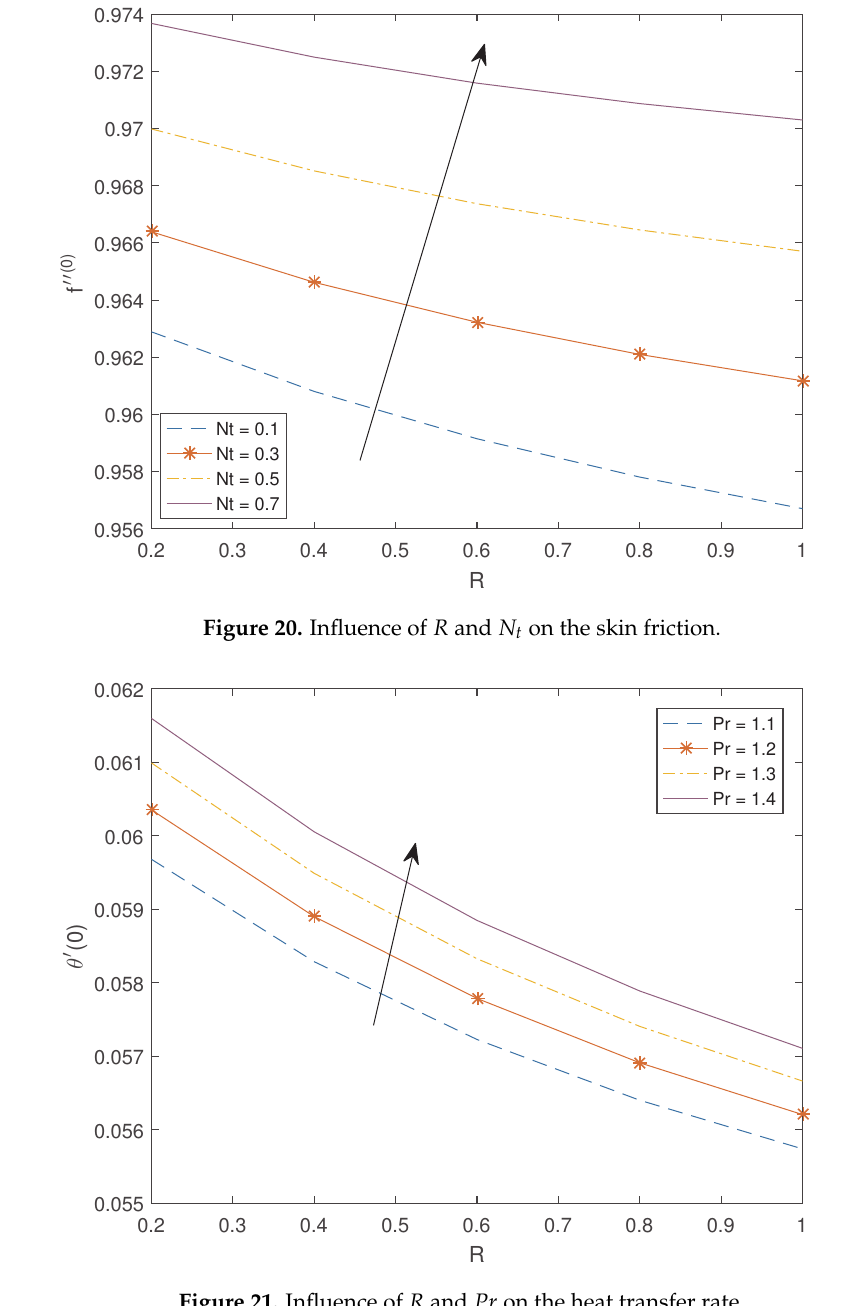
Figure 21. Influence of R and Pr on the heat transfer